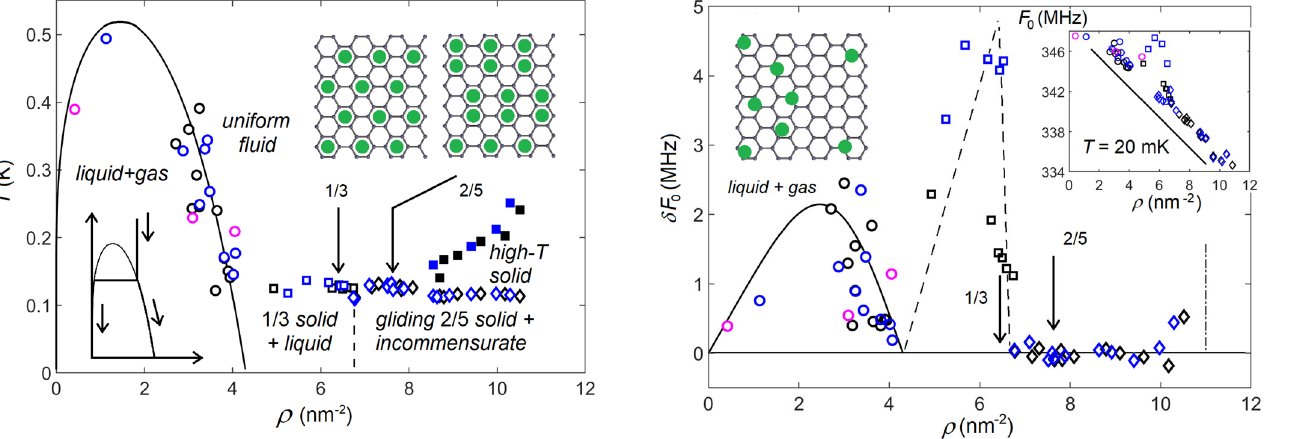
Fig. 3 | Excess δ F 0 of the resonant frequency in the low-temperature phases comparedtotheliquid,seeFig.1(c). Circles:transitionfromclusteredliquid+gas coexistencetoauniform fl uid.The δ F 0 ( ρ )dependenceisdescribedverywellbyEq. (3) in the Methods section (solid curve), see text. Squares: melting of the 1/3 solid. The dashed lines indicate the anticipated fraction of the 1/3 phase. Diamonds: differencebetweenglidingsolidand fl uid(at ρ >8.2nm − 2 theresonantfrequency F 0 wasextrapolatedlinearlyfromglidingsolidthroughhigh- T solidphase).Absenceof the drop ofthe resonant frequencyon melting indicates thatthereisno additional stiffness provided by gliding solid. The insert on the left illustrates liquid-gas coexistence.Theinsertontherightshowsquantumphasetransitionsfrom fl uidto the 1/3 solid and from the 1/3 solid to the soft gliding solid. Dash-dotted line: beginning of the second layer promotion on grafoil 14,33 .